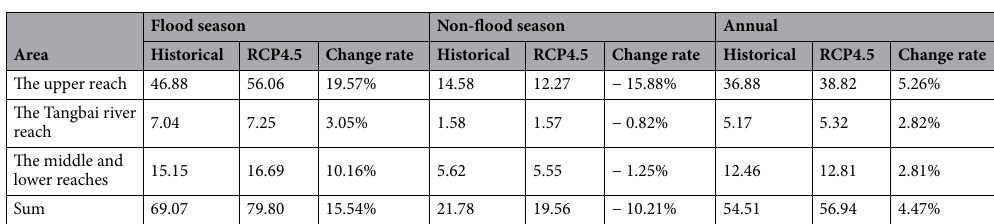
Table 6. Future local water availability change compared with the historical period of the Han River basin (billion m 3 ).